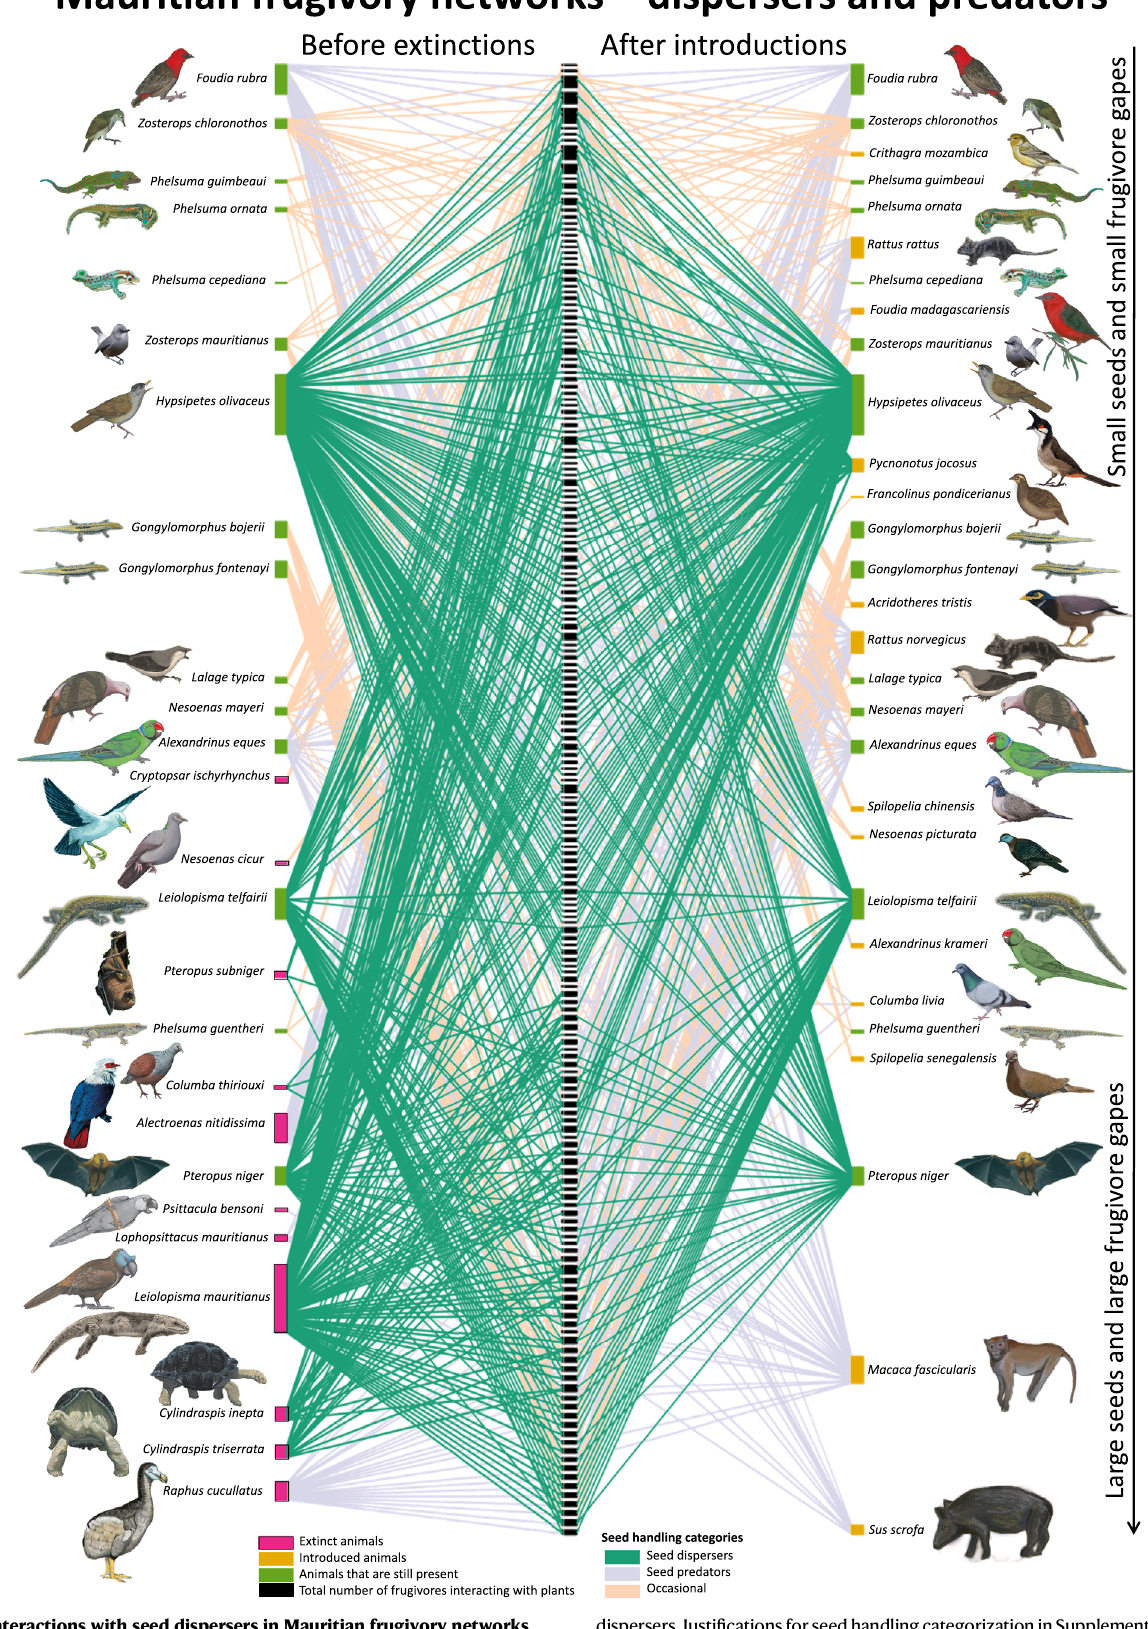
dispersers.Justi fi